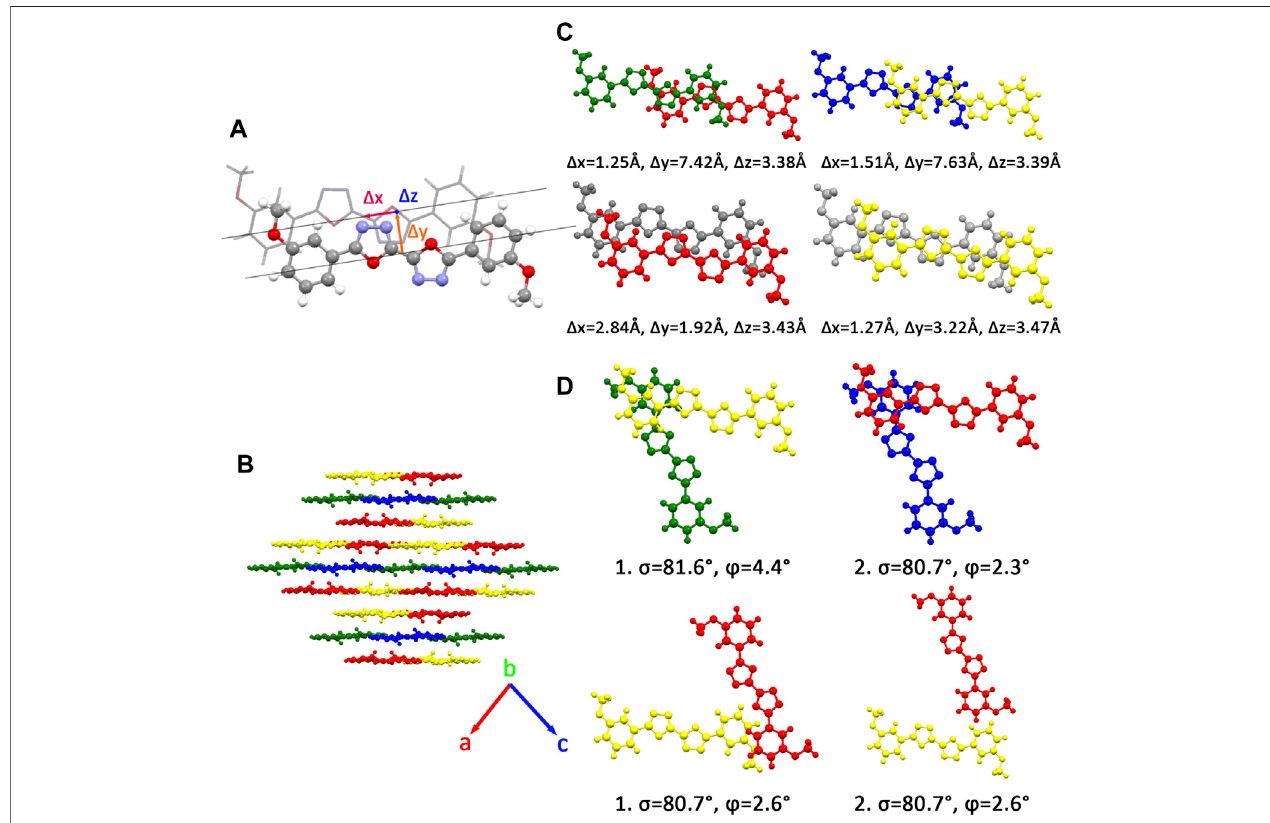
FIGURE 1 | (A) Molecular structure of single molecular BOXD-m . Δ x and Δ y represent the slip distance along the short and long axes, Δ z is the π – π distance. (B) Crystal structure and the crystal cell directions of BOXD-m . (C) Primary relative positions of the bimolecular in π stacking. (The gray molecule has the same color with another molecule in the pairs; we use gray color to better indicate the relative location.) (D) Primary relative positions of the bimolecular in herringbone arrangement with the angle between two long axes ( σ ) and dihedral angle between molecular planes ( φ )